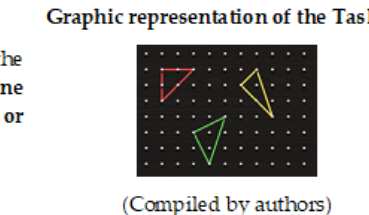
Figure 2. Task 4 of the questionnaire.